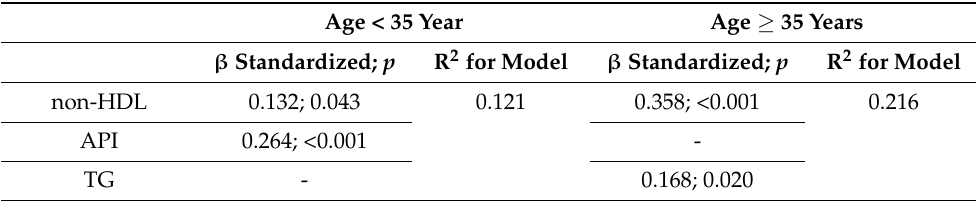
Table 3. Multiple forward stepwise regression analysis of